Question: In a single sentence, describe what this figure presents.
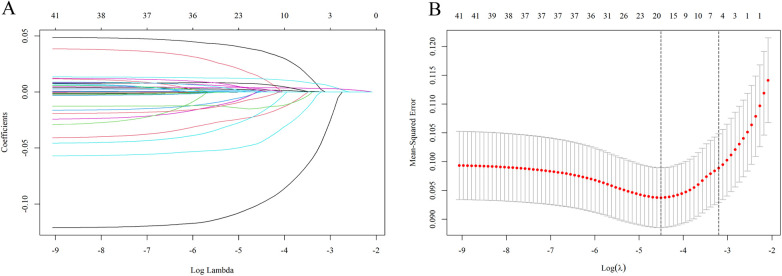
Answer: Variable screening based on lasso regression. (A) Variation features of variable coefficients. (B) The optimal value of the parameter λ in the Lasso regression model is selected through the cross—validation method.